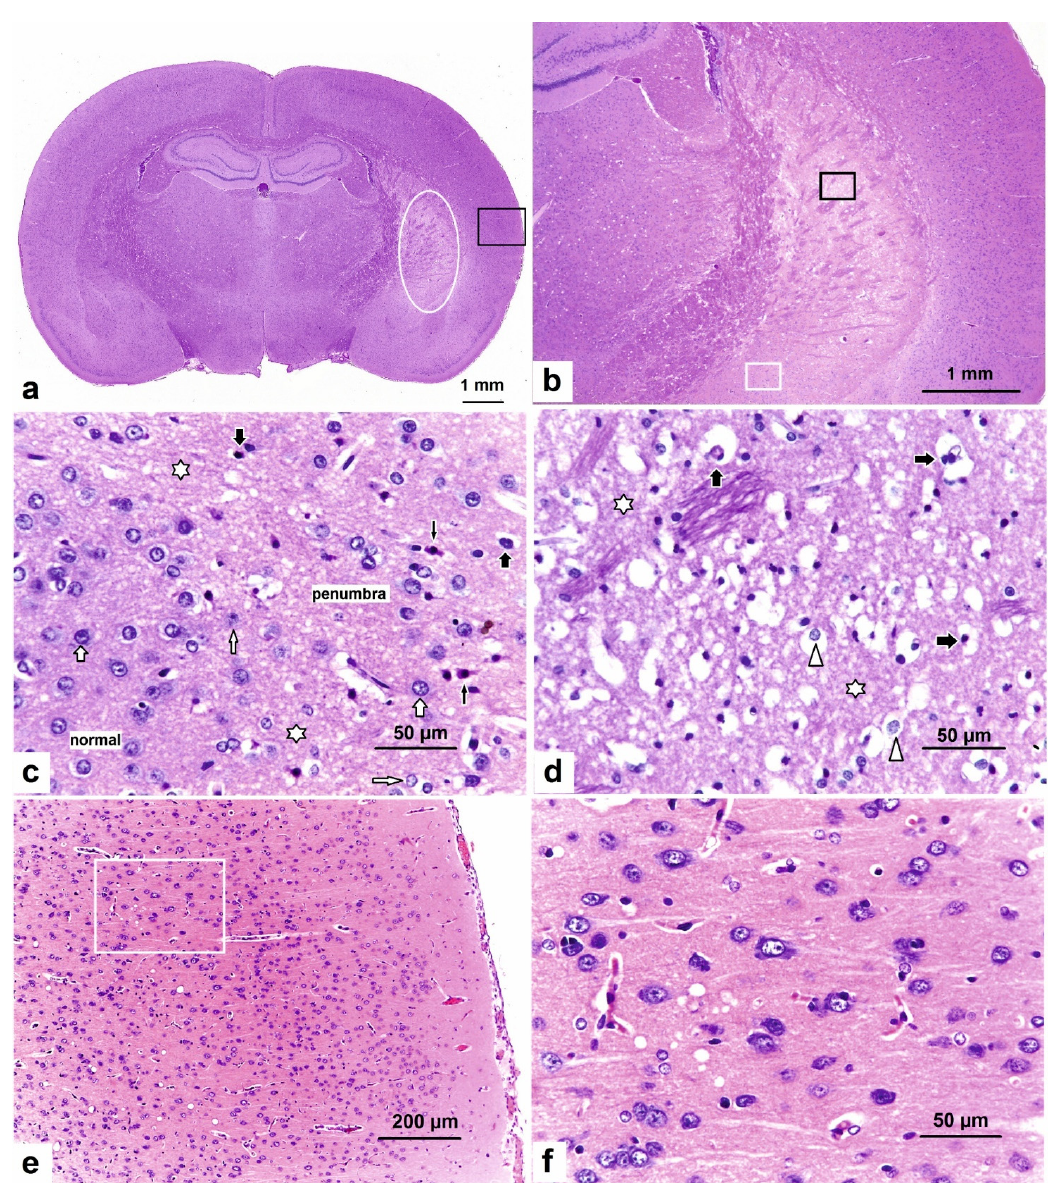
Figure 1. Photomicrographs of H&E-stained sections of the rat brain after 24 h in tMCAO model conditions. ( a ) Coronal rat brain section at the level of –2.5 mm from the bregma. The oval shape indicates the damaged area involving the caudoputamen nucleus of the right hemisphere. The rectangle indicates the secondary somatosensory cortex. ( b ) The zone of ischemic injury of the caudoputamen indicated within panel ( a ) is shown at a higher magnification. ( c ) Area of panel ( b ) marked with a white rectangle. The change zone: from normal to ischemic-injured (penumbra) tissue; intact neurons (thick white arrows); decrease of nuclear basophilia in the neurons (thin white arrows); ischemic damage to neurons, with pyknotic nuclei and pericellular edema (thick black arrows); red neurons (thin black arrows); and vesiculation of the neuropile (white asterisks). ( d ) Area of panel ( b ) marked with a black rectangle. The ischemic core: vacuolation with edema of the neuropile (white asterisks); swollen neurons (white triangles); necrotic cells (thick black arrows); and absence of intact neurons. ( e ) The area of panel ( a ) marked with a rectangle. Normal cytoarchitecture of the secondary somatosensory cortex. ( f ) The area of panel ( e ) marked with a white rectangle. The inner pyramidal (V; ganglionic) layer. The perikarya of large pyramidal cells are filled with basophilic substances.